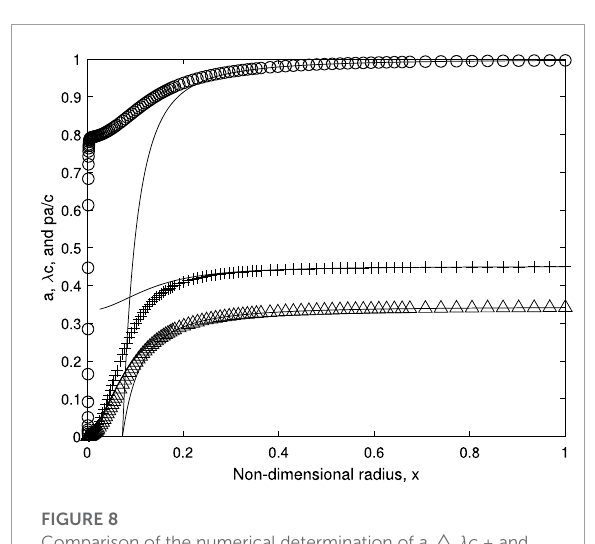
FIGURE 8 Comparison of the numerical determination of a , △ , λ c ,+ and pa / c ,○ , at λ = 8 to the analytic approximation, Equation (A2) .